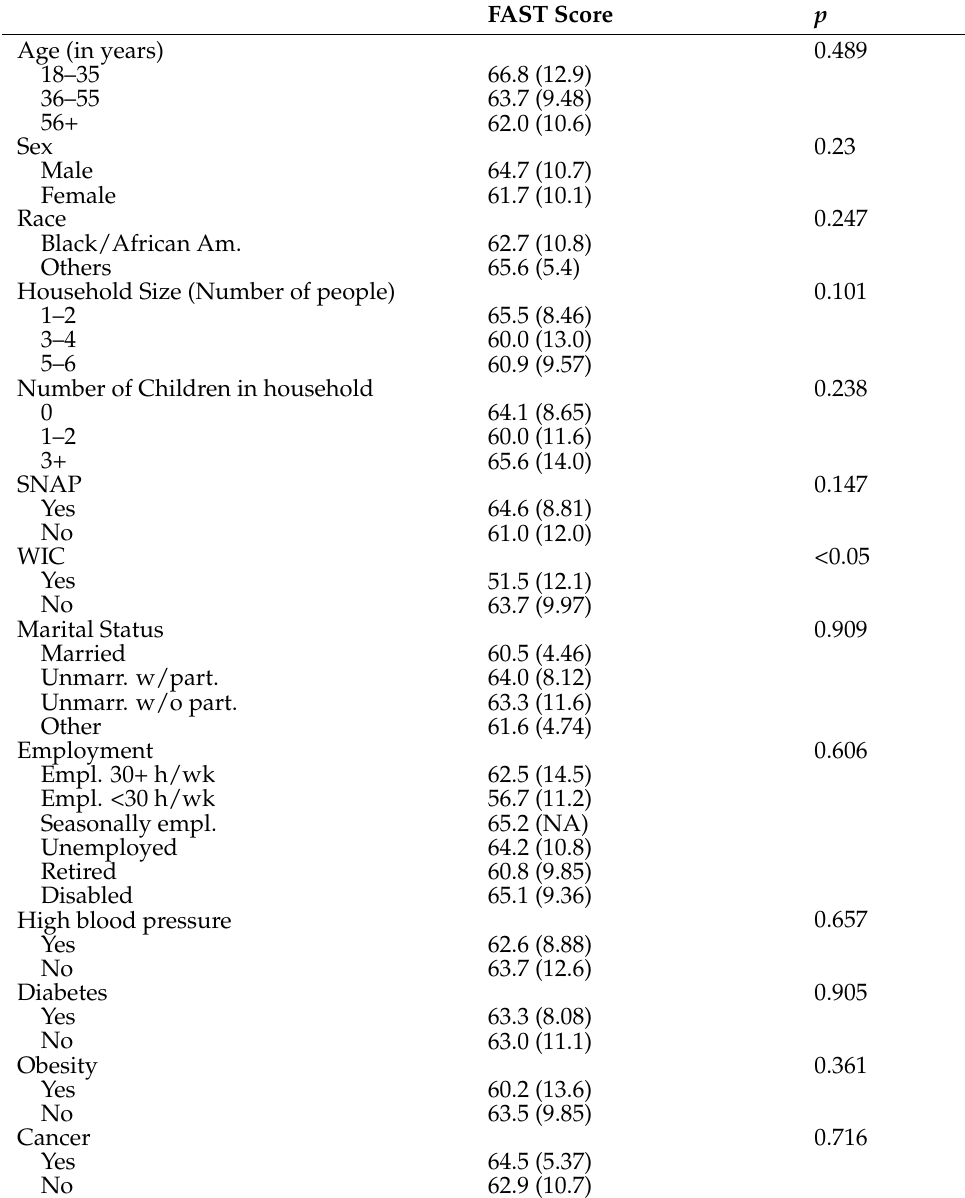
Table 2. FAST scores by client sociodemographic characteristics.